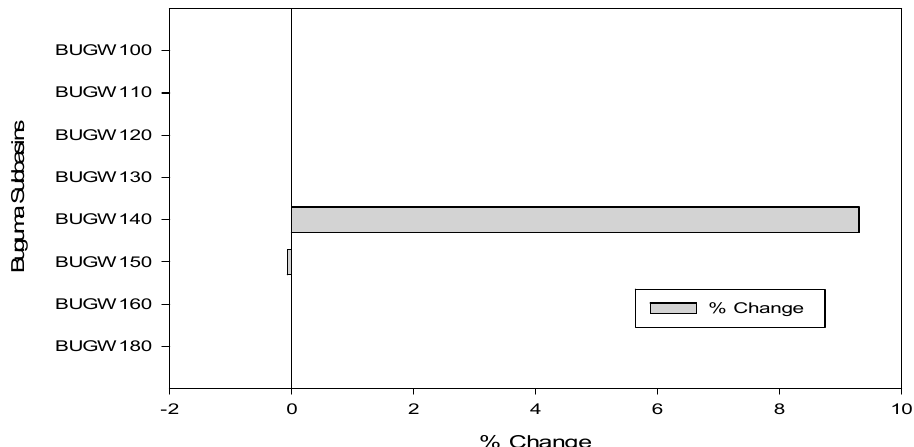
Figure 8. Sub-basin peak flow response to the Phase 1 alternative in the Buguma Basin. Changes in the right direction represent negative changes. It demonstrates that changes in peak flow due to the Buguma alternative was greater than changes in peak flow due to the 2003 conditions. In this basin, sub-basin BUG 140 experienced the highest peak flow.